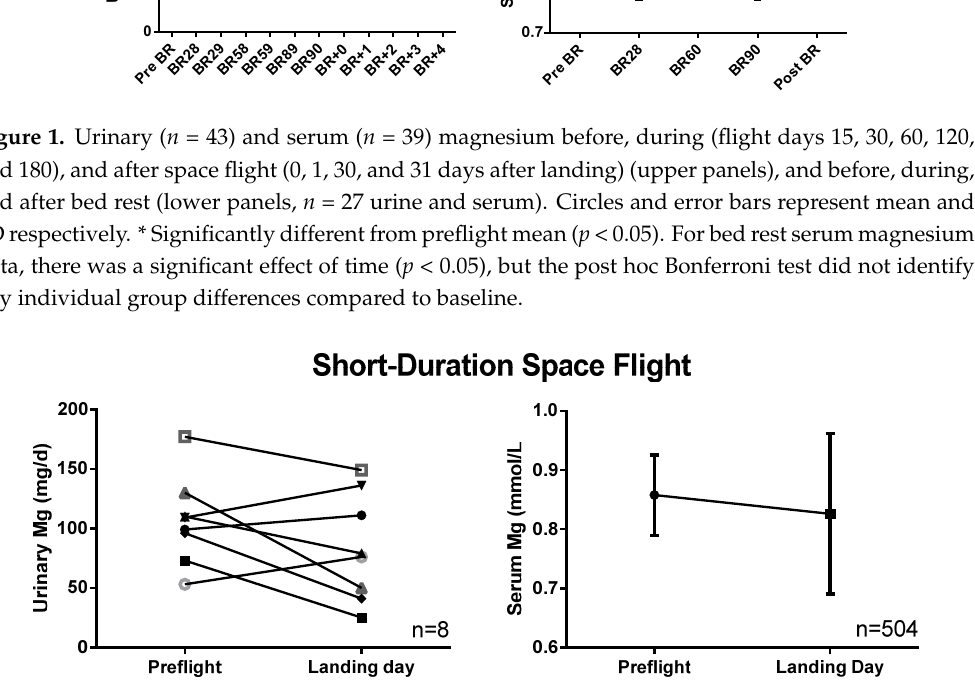
Figure 2. Urinary and serum magnesium after 2 ‐ to 18 ‐ day Space Shuttle flights. The urine data are individual data from a small study evaluating bone and mineral metabolism after flight, whereas the serum data are means ± SD from routine pre ‐ and postflight medical testing, and thus have a much larger n .